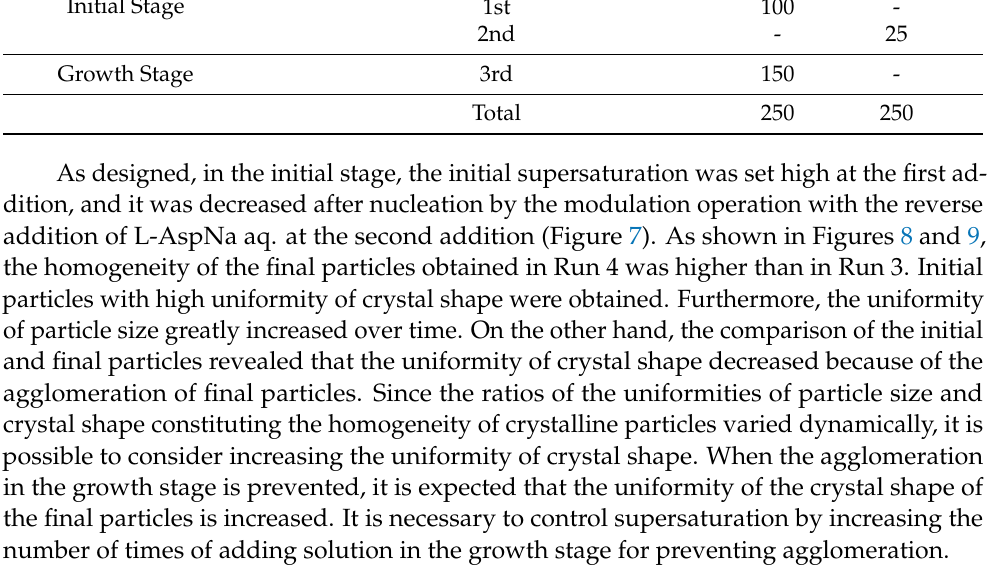
Table 2. The detailed addition methods in Run